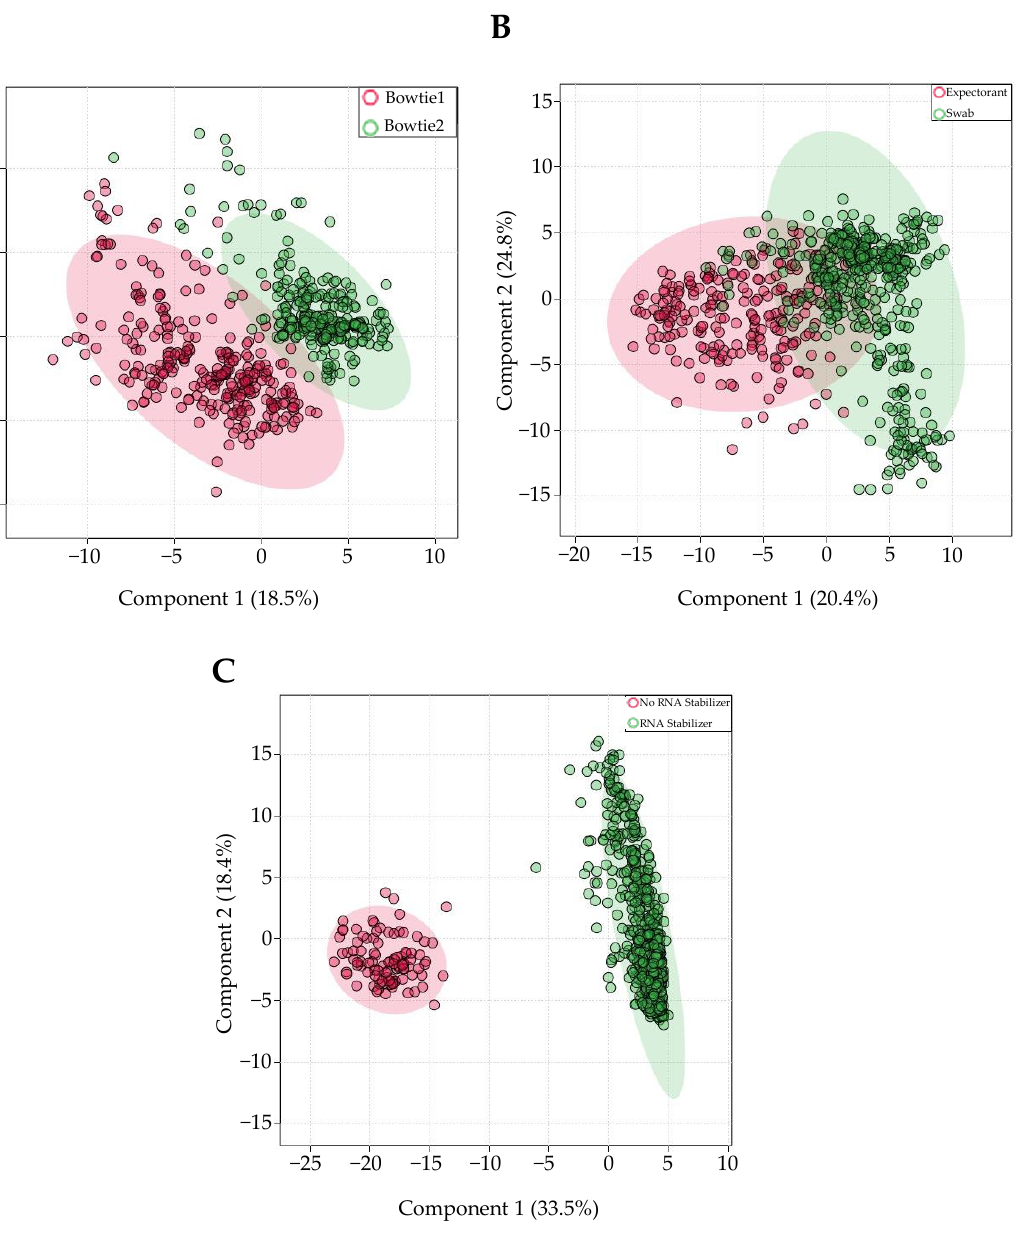
Figure 2. Salivary miRNA expression is affected by differences in three technical factors. PLS-DA plot of 291 samples that were aligned with both Bowtie1 and Bowtie2 for within subject comparison ( A ). For PLS-DA plots visualizing differences in methods of collection ( B ) and use of RNA stabilizer ( C ), 734 samples were used.